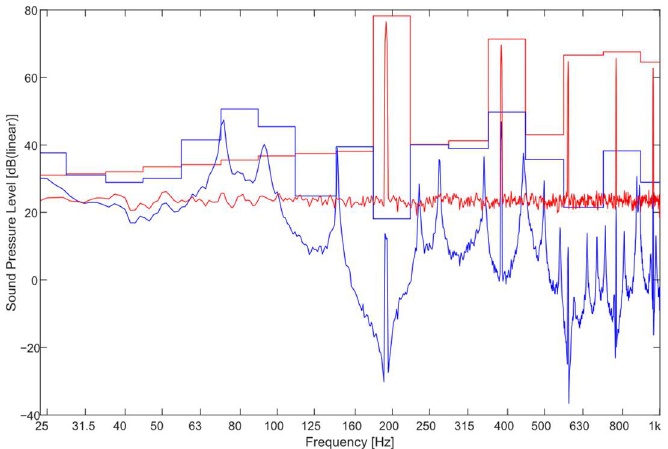
Figure 18. Resulting SPL narrow band and one-third octave band spectra at the receiver. Blue lines: without silencing system. Red lines: with silencing system.